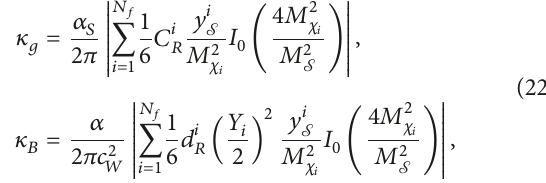
level (CL) on the cross sections for the resonance mass of 1 TeV of four type of resonances is given